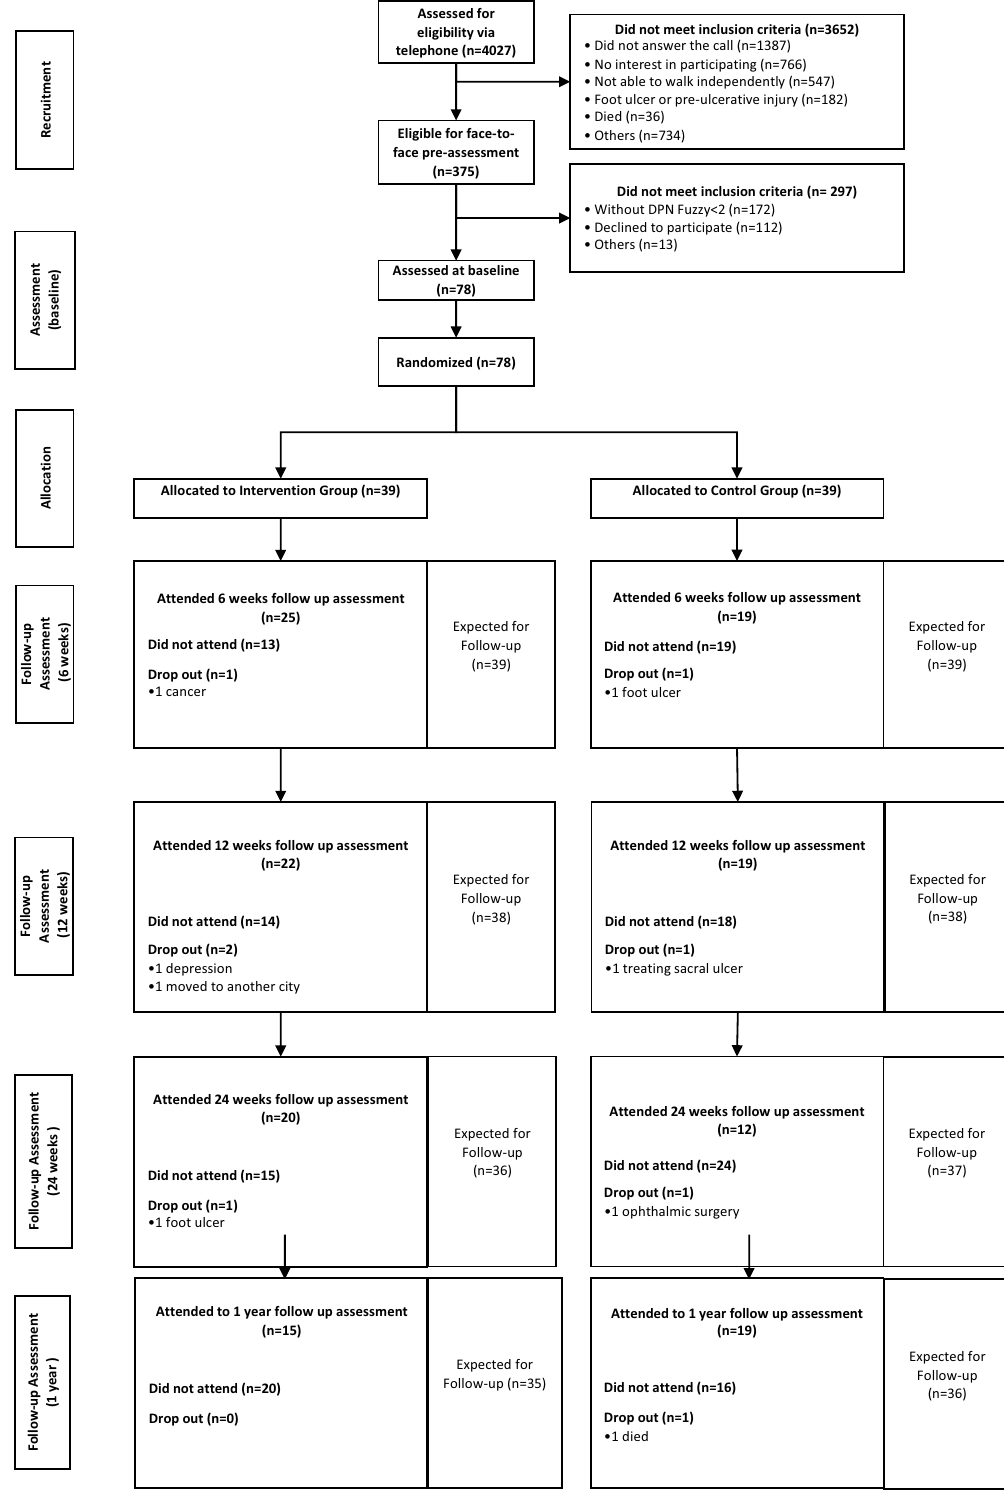
Figure 1. Flowchart of recruitment, assessment, and follow-up